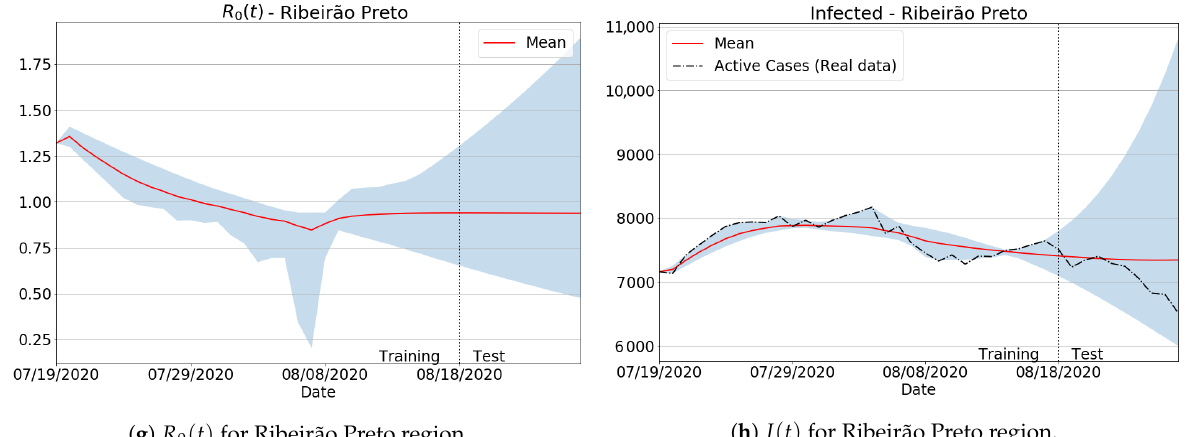
Figure 6. Reproduction number R 0 ( t ) and infected I ( t ) predictions for the mean, minimum and maximum forecasted values as the training window moves, i.e., by varying M = 10,11,...,40 in Equation (2) and training the parameters in a coupled and recursive way. Red lines establish the mean predicted values after the full learning procedure is finished, while the vertical dotted lines split the training and forecasting periods.